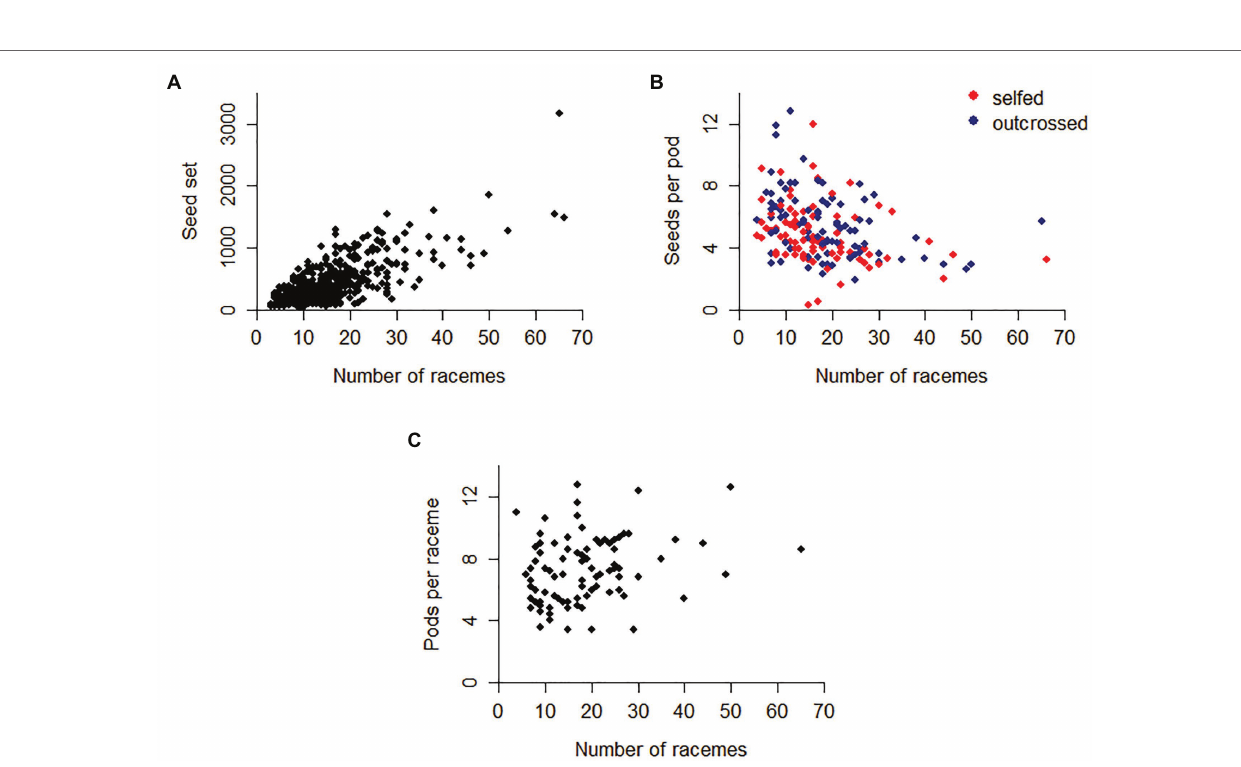
FIGURE 3 | Number of racemes per stem and yield metrics. Stems with more racemes have (A) higher seed set ( p < 0.0001), (B) fewer seeds per pod in CEV for both selfed ( p = 0.01) and outcrossed ( p = 0.0005) stems, and (C) more pods per raceme in CEV for outcrossed stems ( p = 0.014). The r 2 values for the full models are presented in Table 5